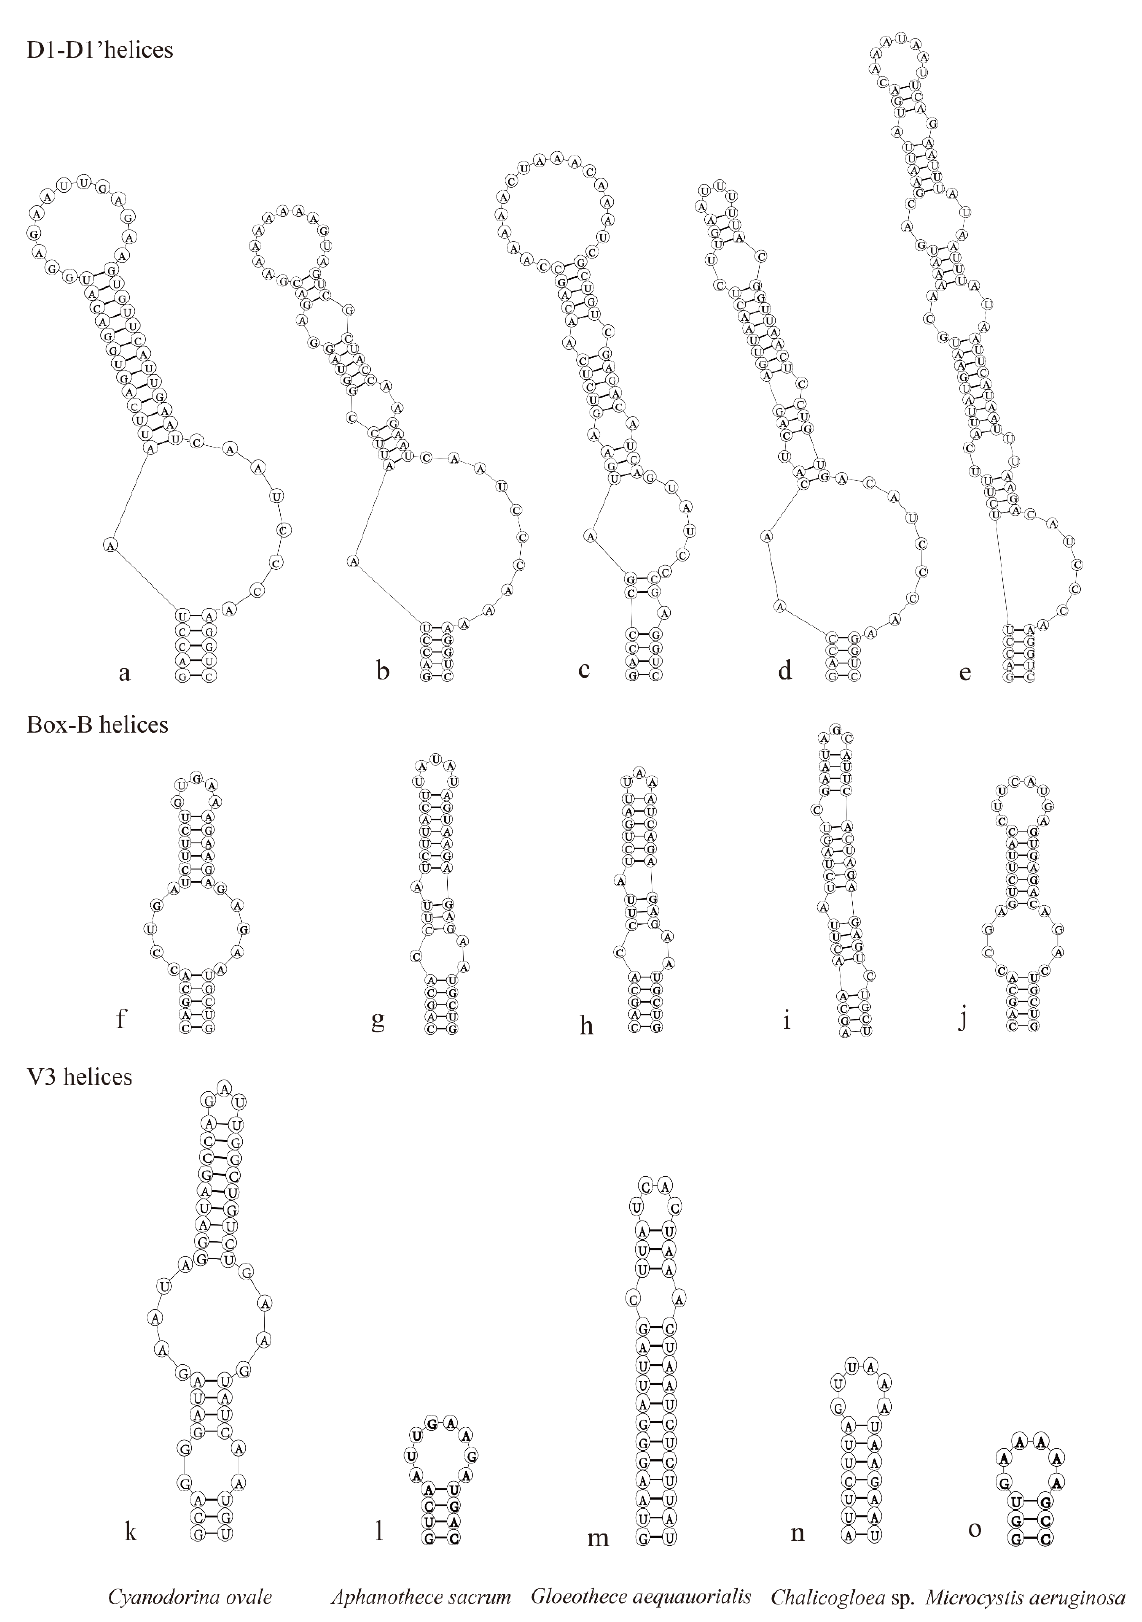
Figure 4. Secondary structures of D1 – D 1′ helices ( a – e ), Box-B helices ( f – j ) and V3 helices of various taxa. ( a , f , k ) Cyanodorina ovale CH01. ( b , g , l ) Aphanothece sacrum FPU3. ( c , h , m ) Gloeothece aequauorialis SAG 36.87. ( d , i , n ) Chalicogloea sp. BACA0589. ( e , j , o ) Microcystis aeruginosa UUEX ‘ B 2667.